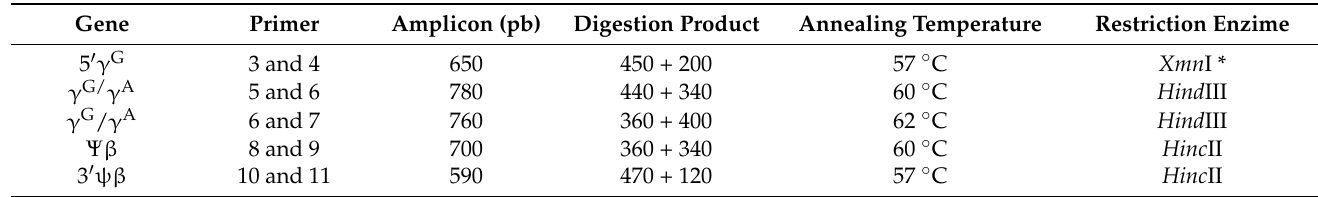
Table 1. Primers and PCR-RFLP conditions for β S globin gene cluster